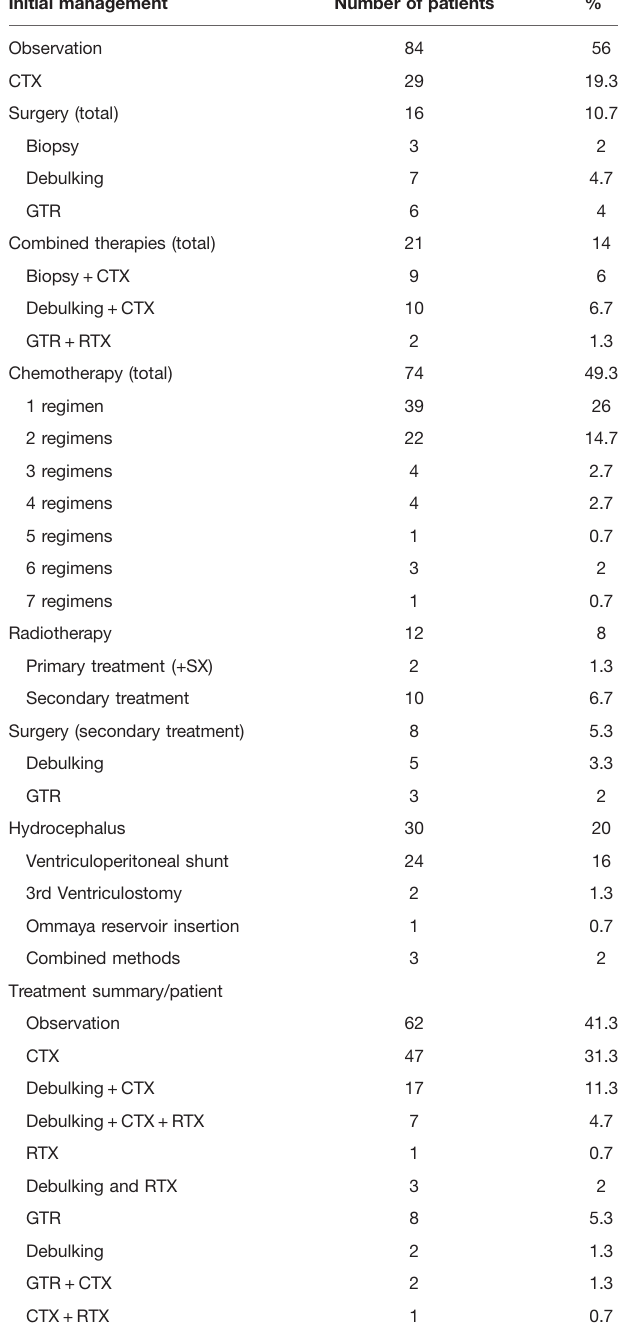
TABLE 2 | Treatment